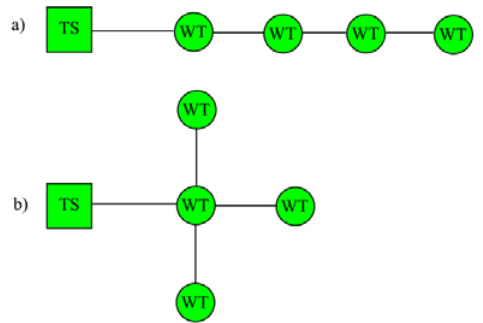
Figure 5. Graphical depiction of the: ( a ) cascade and ( b ) parallel ( i.e. , star configuration) wind farm